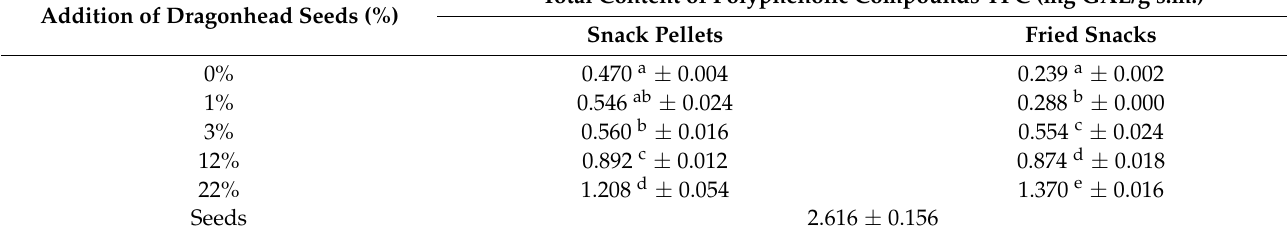
Table 1. Total content of polyphenolic compounds (TPC) in snack samples depends on dragonhead seed addition and thermal treatment ( n = 3 mean ± SD). Total Content of Polyphenolic Compounds TPC (mg GAE/g s.m.) Addition of Dragonhead Seeds (%) Snack